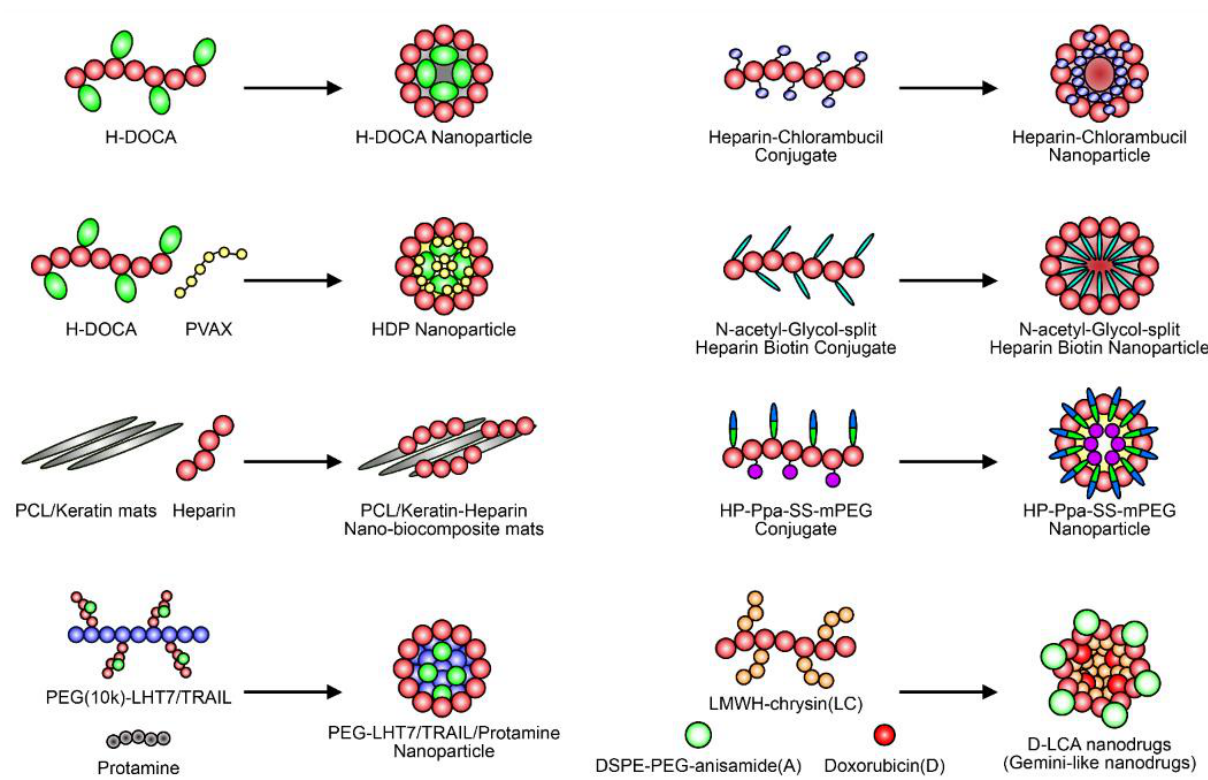
Figure 4. The schematic structures of nanoparticles based on heparin derivatives. Different types of heparin conjugates are currently being investigated as nanodrug carriers or new drug candidates. The self-assembled heparin – drug conjugate that forms after nanoformulation has shown great therapeutic potential for use in various therapies.